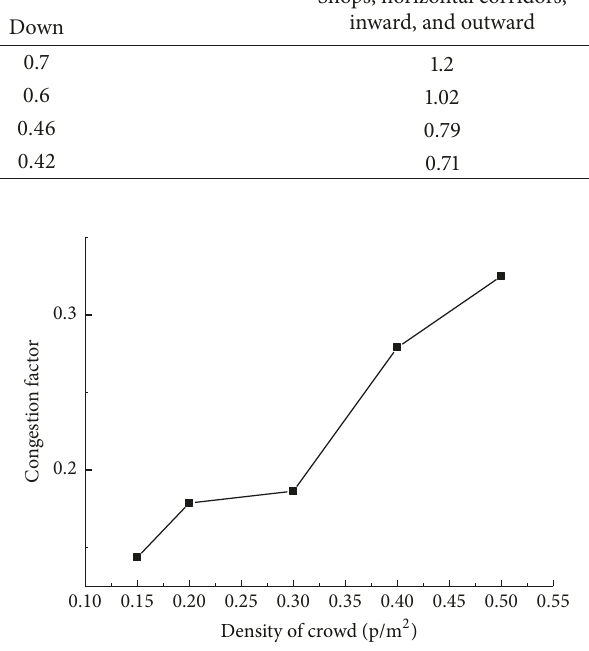
Figure 5: Congestion factor without shunt